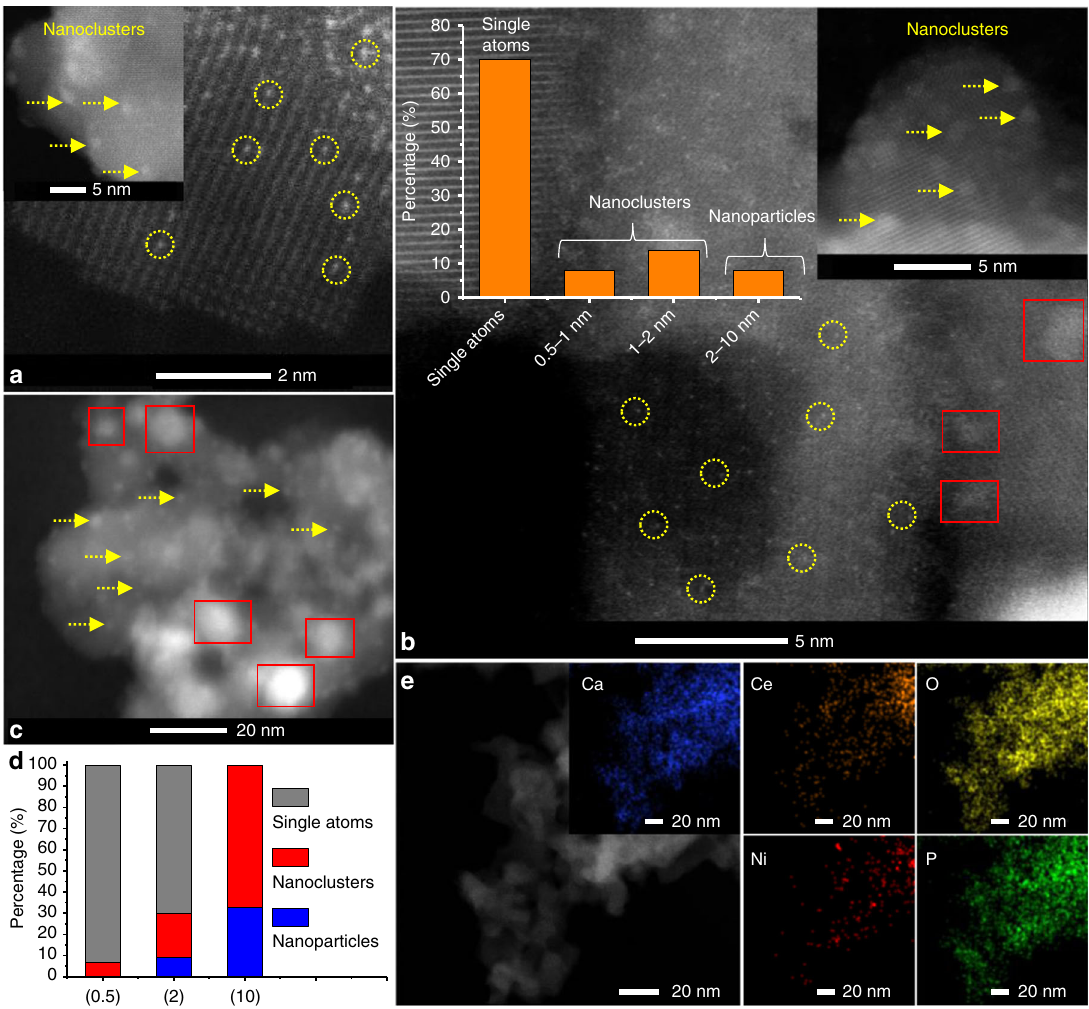
Fig. 1 Electron microscopy images and size distribution of Ni/HAP-Ce samples. a HAADF-STEM images of 0.5Ni 1 /HAP-Ce, b 2Ni 1 /HAP-Ce, and c 10Ni/ HAP-Ce samples after 500 °C H 2 reduction. d particle size distributions of a – c ; yellow circles indicate atomically dispersed Ni and red squares indicate Ni